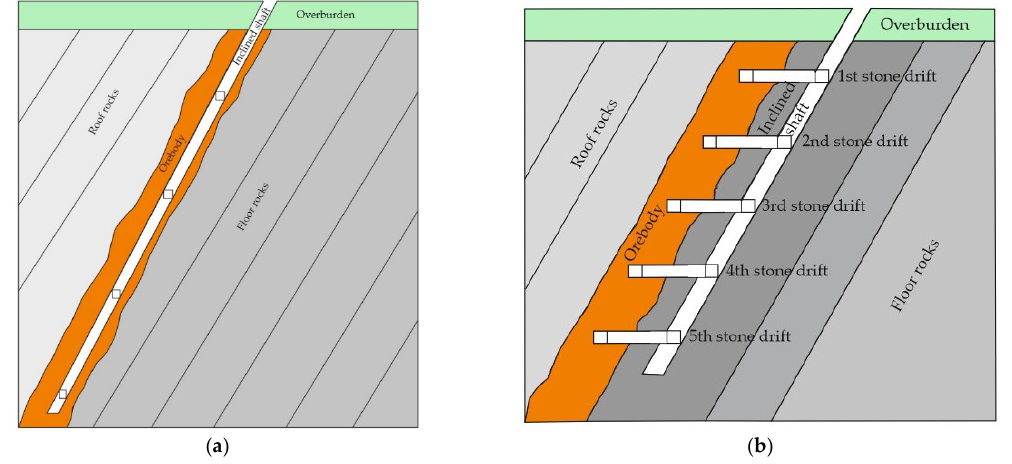
Figure 5. Access by Means of Inclined Shaft: ( a ) In the deposit; ( b ) In the floor